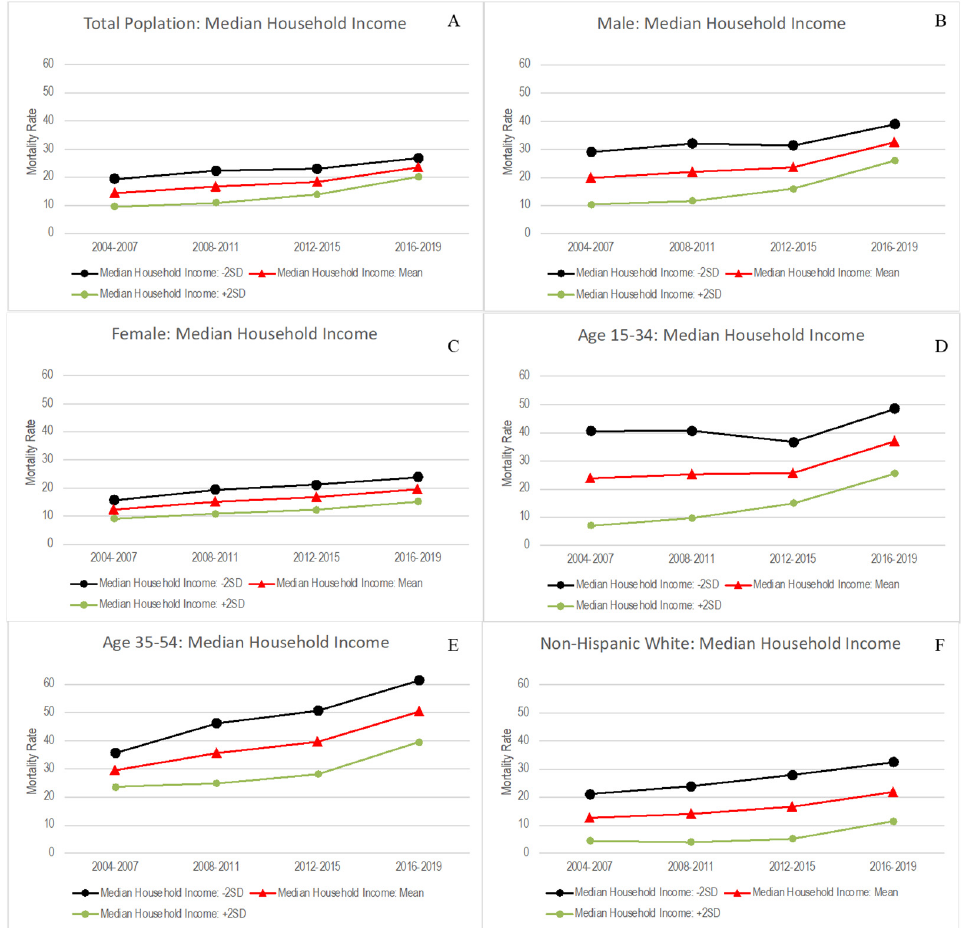
Figure 3. Predicted trajectories of county-level drug mortality rates with varying levels of county- level median household income among the total population and sociodemographic subgroups: The Wide-Ranging Online Data for Epidemiologic Research, 2004–2019. ( A ) Drug mortality rates by median household income levels in the total population; ( B ) Drug mortality rates for males by median household income levels; ( C ) Drug mortality rates for females by median household income levels; ( D ) Drug mortality rates for those aged 15–34 years by median household income levels; ( E ) Drug mortality rates for those aged 35–54 years by median household income levels; ( F ) Drug mortality rates for non-Hispanic White individuals by median household income levels.